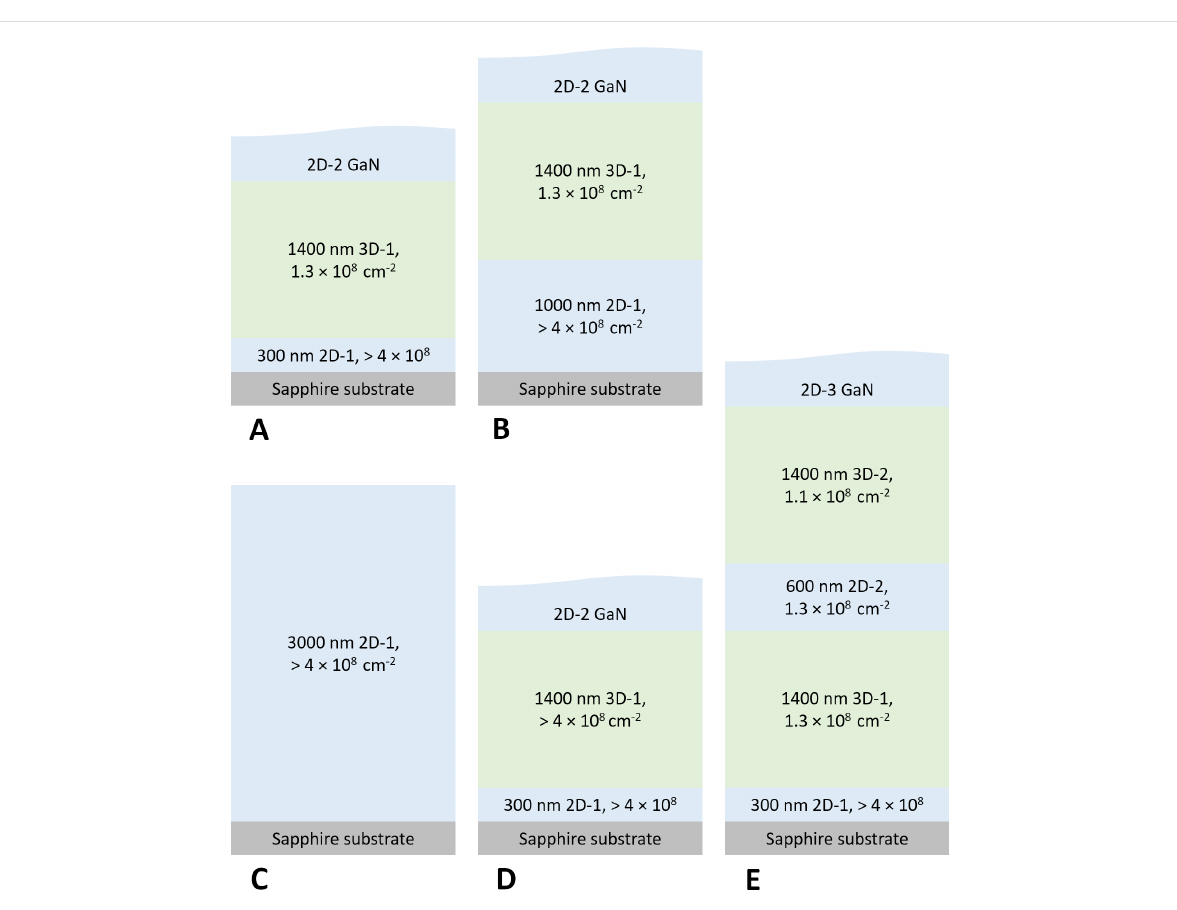
Usually 3D growth was applied in the layer closest to the sub-